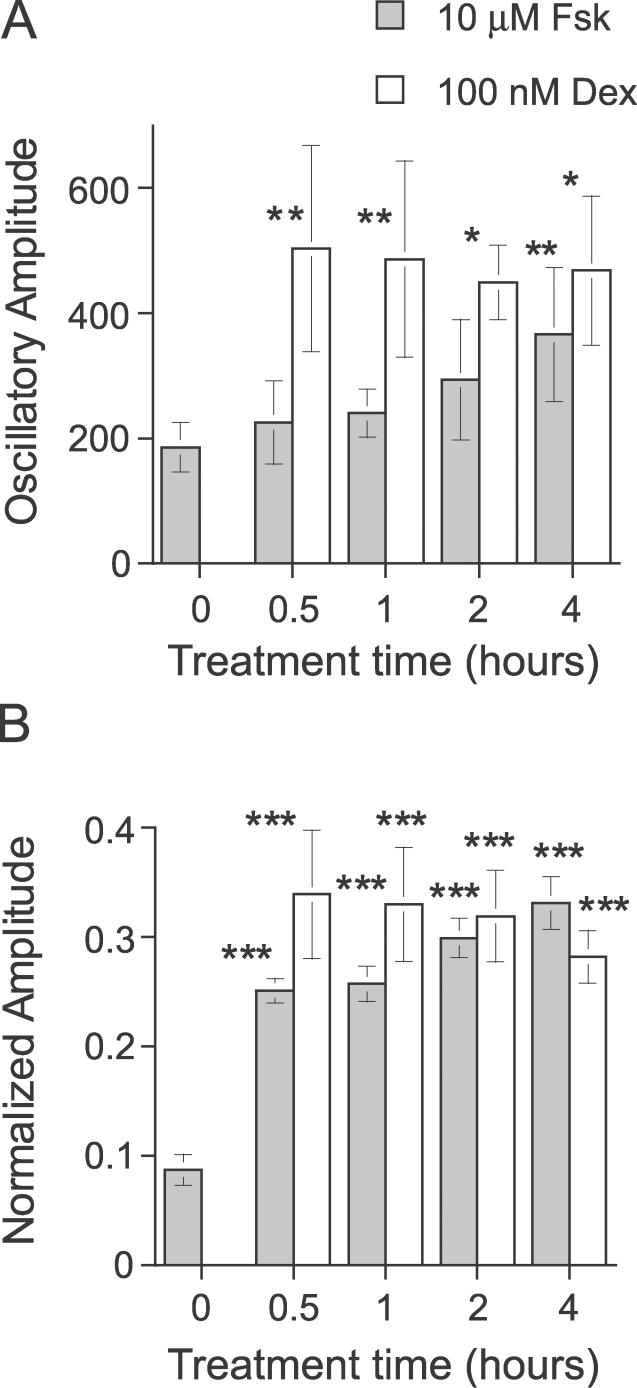
Histogram Representation of the Oscillatory Amplitude Calculations in Table 2
The gray bar is from 10 μM Fsk data; the clear bar is from 100 nM Dex data. Error bars are ± SD. *Statistical significance (p < 0.05) as compared to the medium change (0 h) control. (A) Absolute oscillatory amplitude. (B) Normalized oscillatory amplitude.